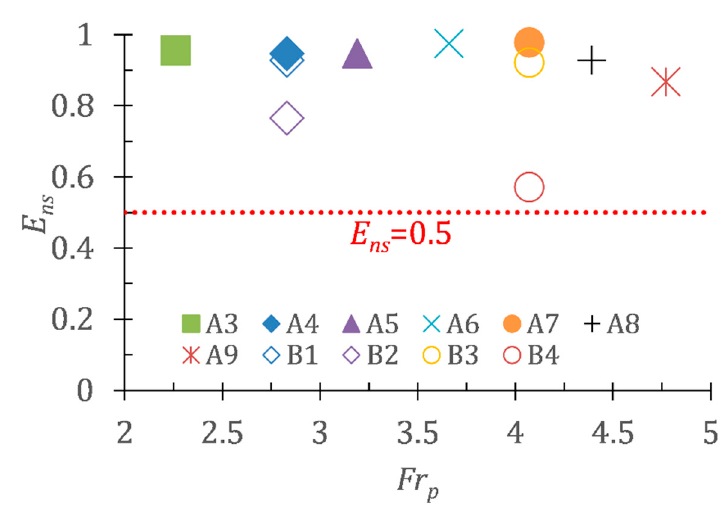
Figure 22. Nash–Sutcliffe efficiency coefficients of Cases A3~A9 ( Fr p = 2.26~4.77) and B1~B2 ( Fr p = 2.83) and B3~B4 ( Fr p = 4.07).